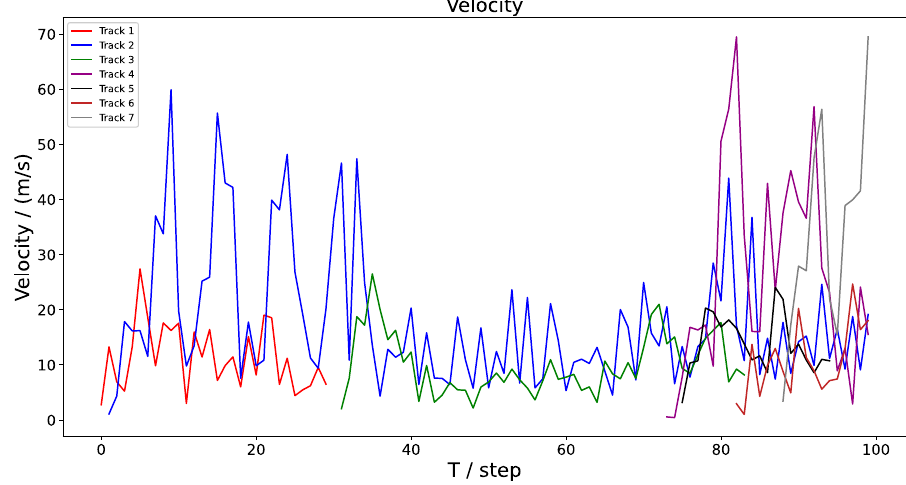
Figure 29. Multi-target velocity estimation (REMTT).